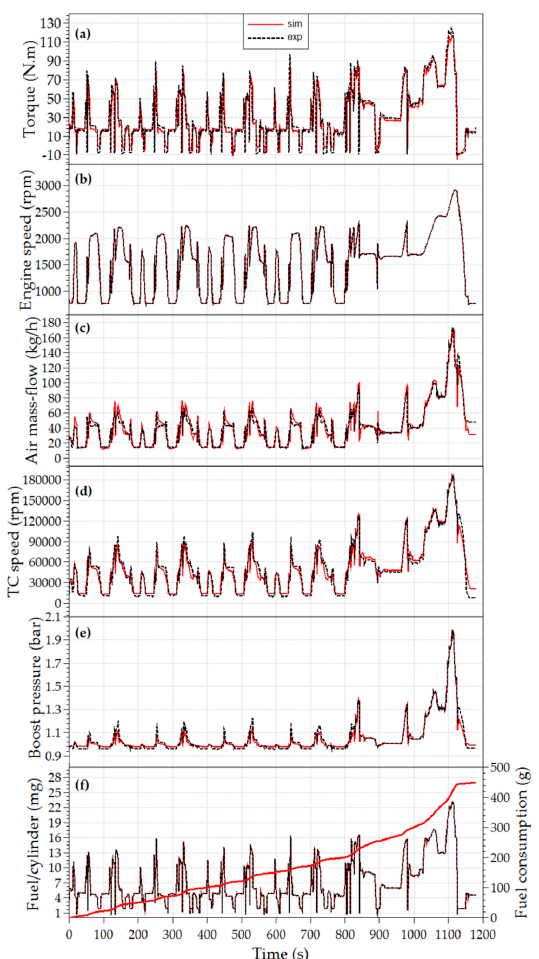
Figure C1. Comparisons of simulation (sim) and measurement (exp) results during engine hot transient NEDC operation at given engine speed and injected fuel: ( a ) Engine torque; ( b ) Engine speed; ( c ) Air mass-flow; ( d ) Turbocharger speed; ( e ) Boost pressure p 21 ; ( f ) Instantaneous and cumulated fuel consumption.